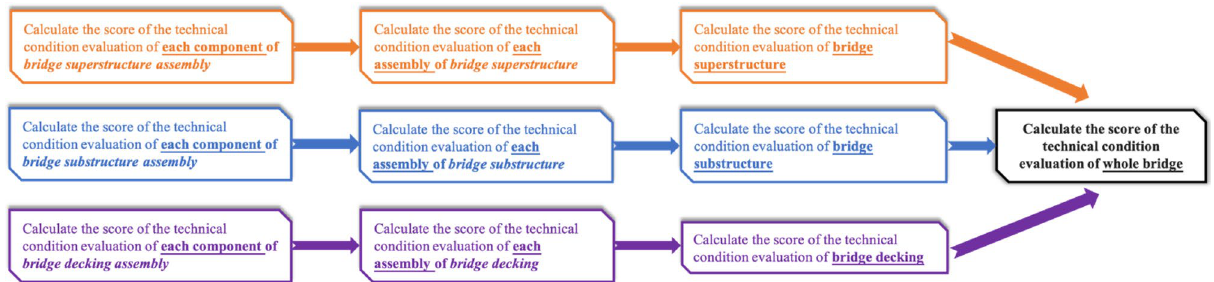
Figure 6. Flow of bridge technical condition evaluation calculation.